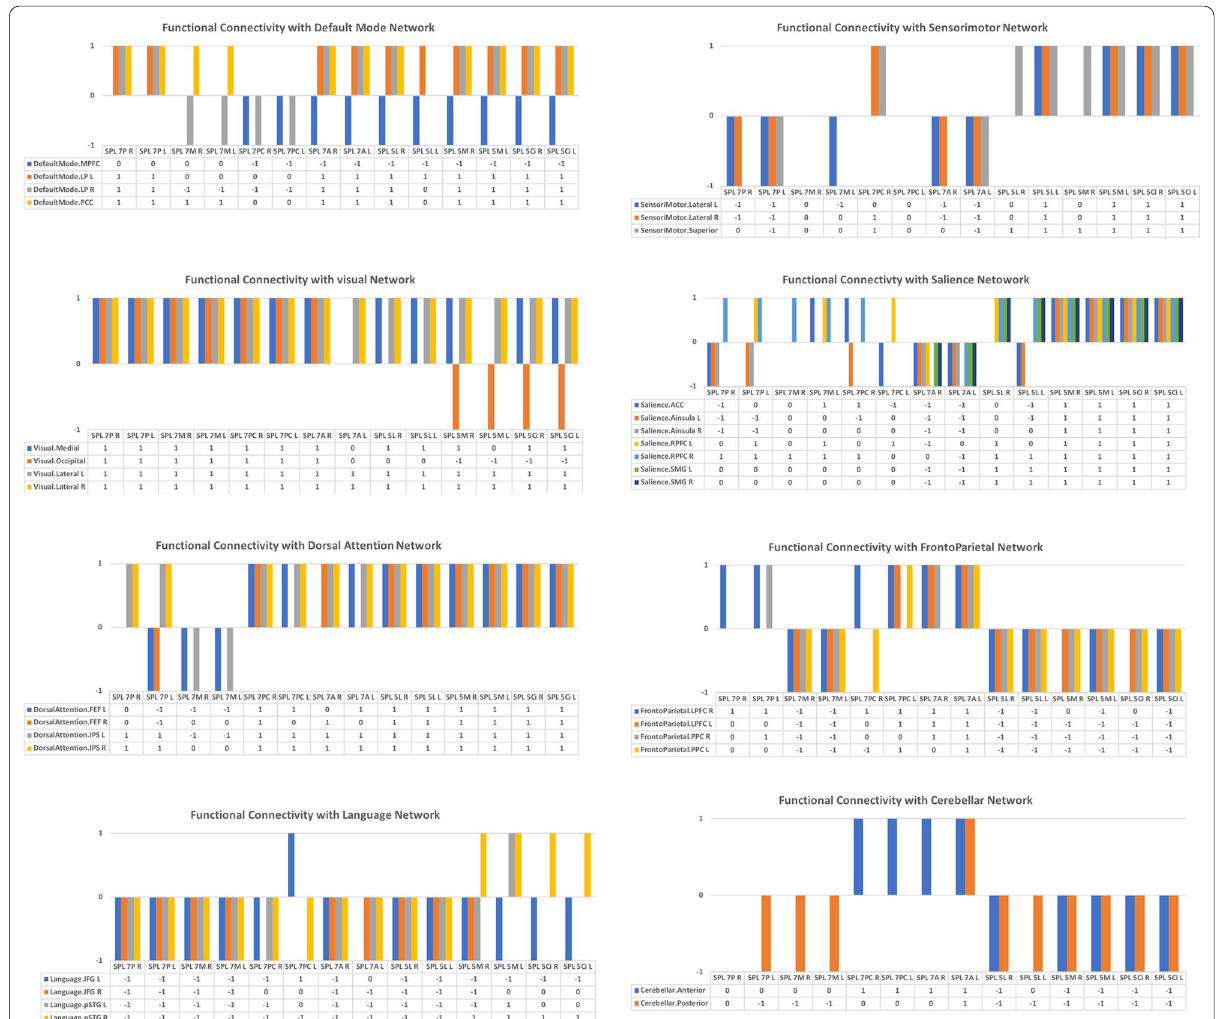
connected positively ( 1), is not connected (0) or is connected negatively (-1) with the eight targeted +